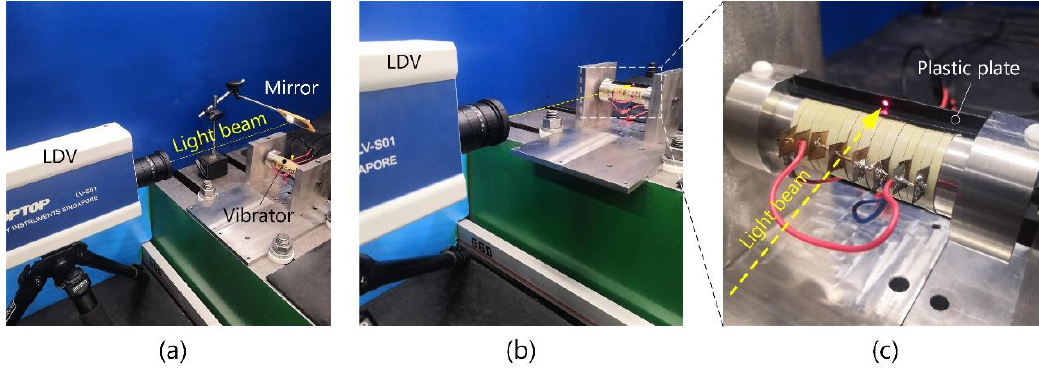
Figure 5. Experimental setup for measuring ( a ) flexural and ( b ) torsional vibration velocity distributions. ( c ) shows the plastic plate bonded onto the vibrator.